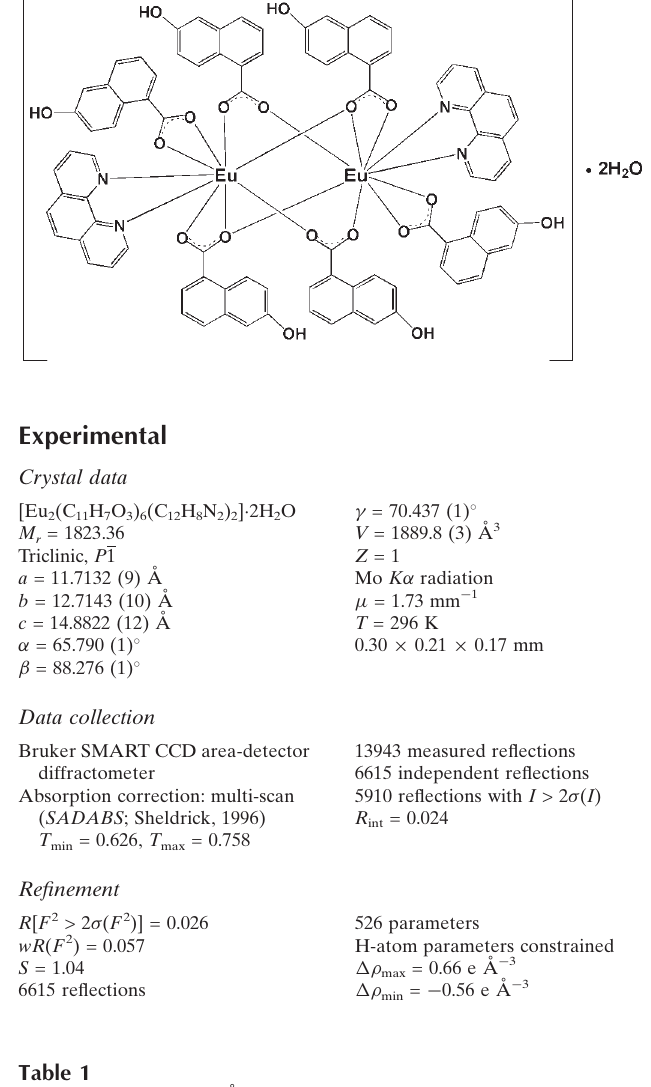
Selected bond lengths (A˚ ).